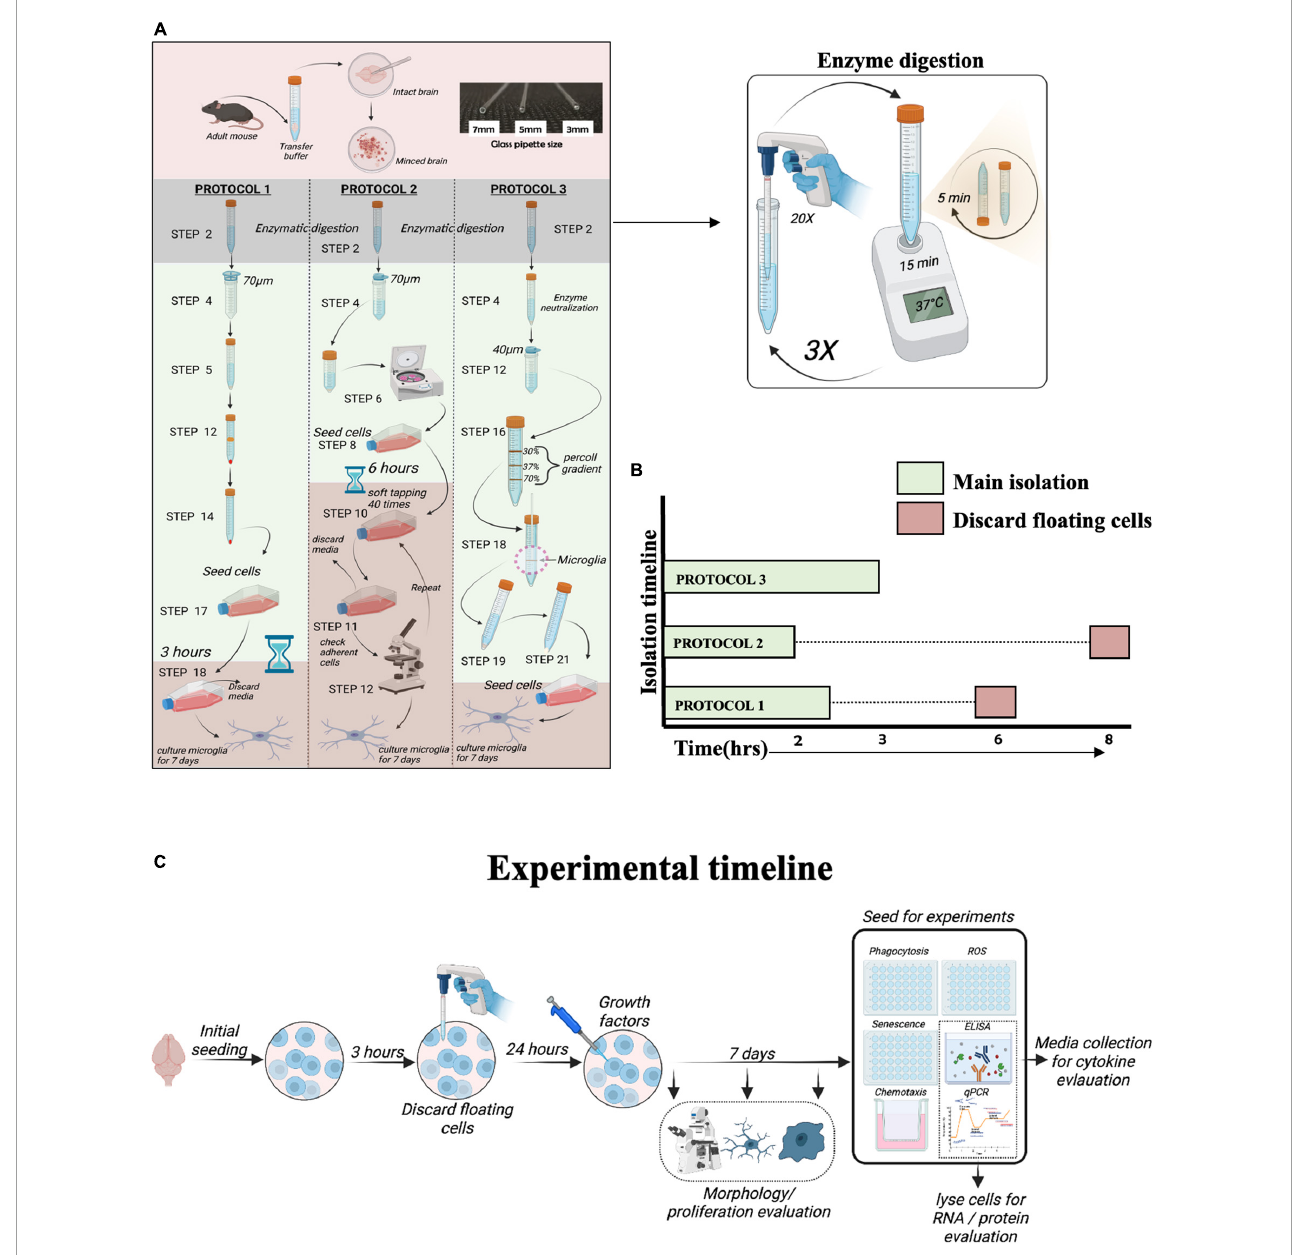
FIGURE1 Overview of protocols for microglia isolation. (A) Schematic representation of the protocols used to isolate adult mouse microglia. (B) The total duration of isolation for each protocol. (C) Schematic diagram of experimental